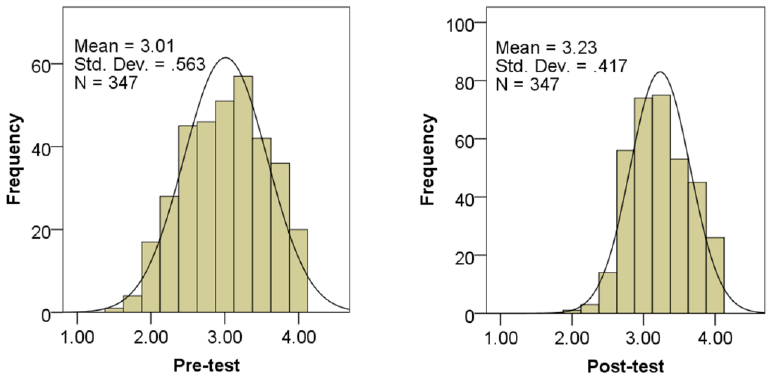
Fig. 2. Histograms of the pre- and post-test data